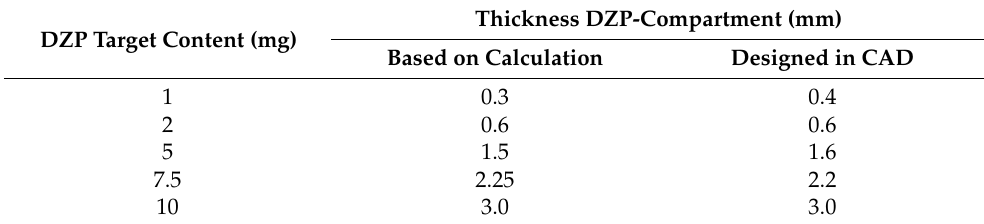
Table 1. Thickness of the diazepam (DZP) compartment to achieve the desired DZP